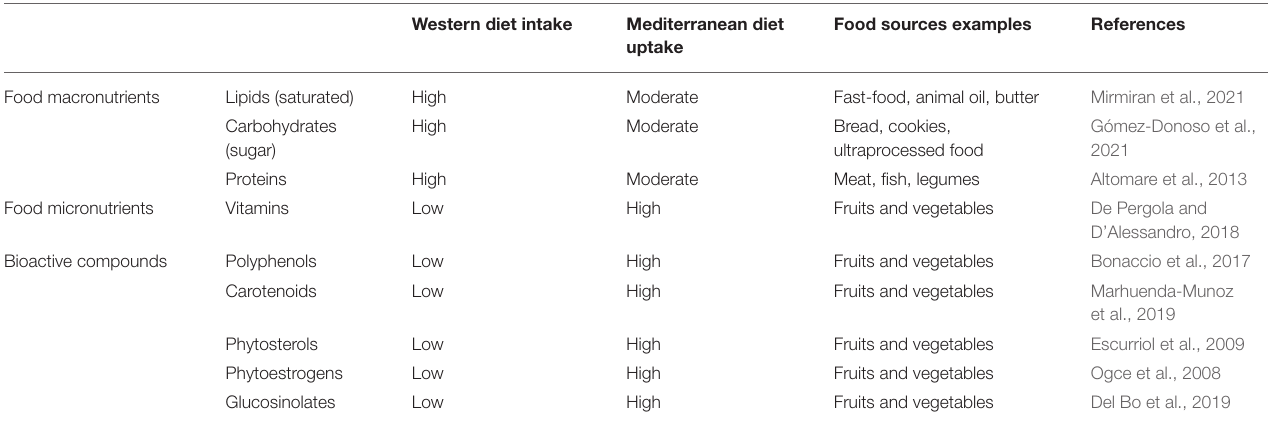
TABLE 3 | Comparison between Mediterranean diet and Western